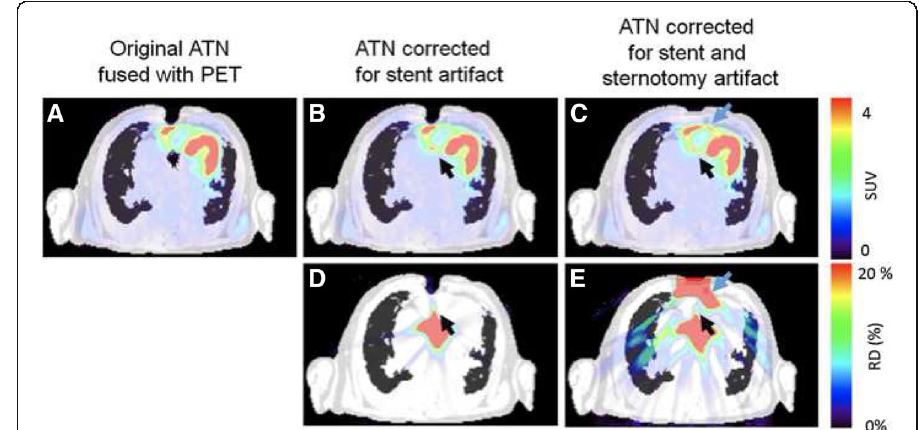
Fig. 2 Artifacts in AC-map and AC-PET caused by foreign bodies. Foreign bodies such as sternal wires and artificial heart valves may cause artifacts in the AC-map, which translates into AC-PET ( a overlay of original AC-map and resulting AC-PET). Corrections of the AC-map ( b correction of susceptibility artifact by artificial aortic valve, c correction of both artifacts caused by artificial aortic valve and sternal wires) may have a significant effect of about 20% on subsequently calculated AC-PET (relative differences of the corrected AC- PET vs. non-corrected AC-PET, d artificial aortic valve, e artificial aortic valve and sternal wires). AC attenuation correction, ATN attenuation. (Reprinted with permission from Lassen, M.L., Rasul, S., Beitzke, D. et al. J. Nucl.